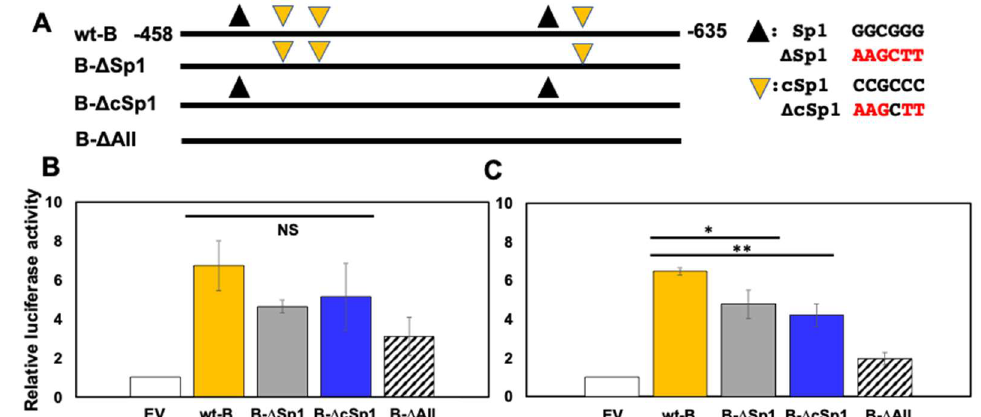
Figure 4. Localization of ICP0 B fragment CRM activity. ( Panel A ): ICP0 wt-B fragment, location of Sp1 and cSp1 binding sites, and fragment B mutants are shown. Nucleotide position numbers are relative to the transcription initiation site of ICP0 mRNA. All constructs were cloned into pGL4.24[luc2P/minP]. The nucleotide sequence of Sp1, cSp1 sites, and their mutated form (red) is shown to the right of the figure. Neuro-2A ( Panel B ) or Vero ( Panel C ) cells were incubated in 2% stripped FBS and transfected with 0.5 ug of wt-B construct or denoted B mutant construct and a Renilla luciferase plasmid (0.05 ug). 48 hrs after transfection, cells were harvested, and dual luciferase assay was performed. Fold activation was calculated relative to pGL4.24[luc2P/minP] or empty vector (EV) for each construct. Results are the mean of three experiments, and error bars denote standard error. The * and ** denote a significant difference of p < 0.05 and p < 0.005 respectively compared to the wt-B CRM luciferase activity as determined by Student’s t-test. Statistical analysis was performed as described in Materials and Methods.